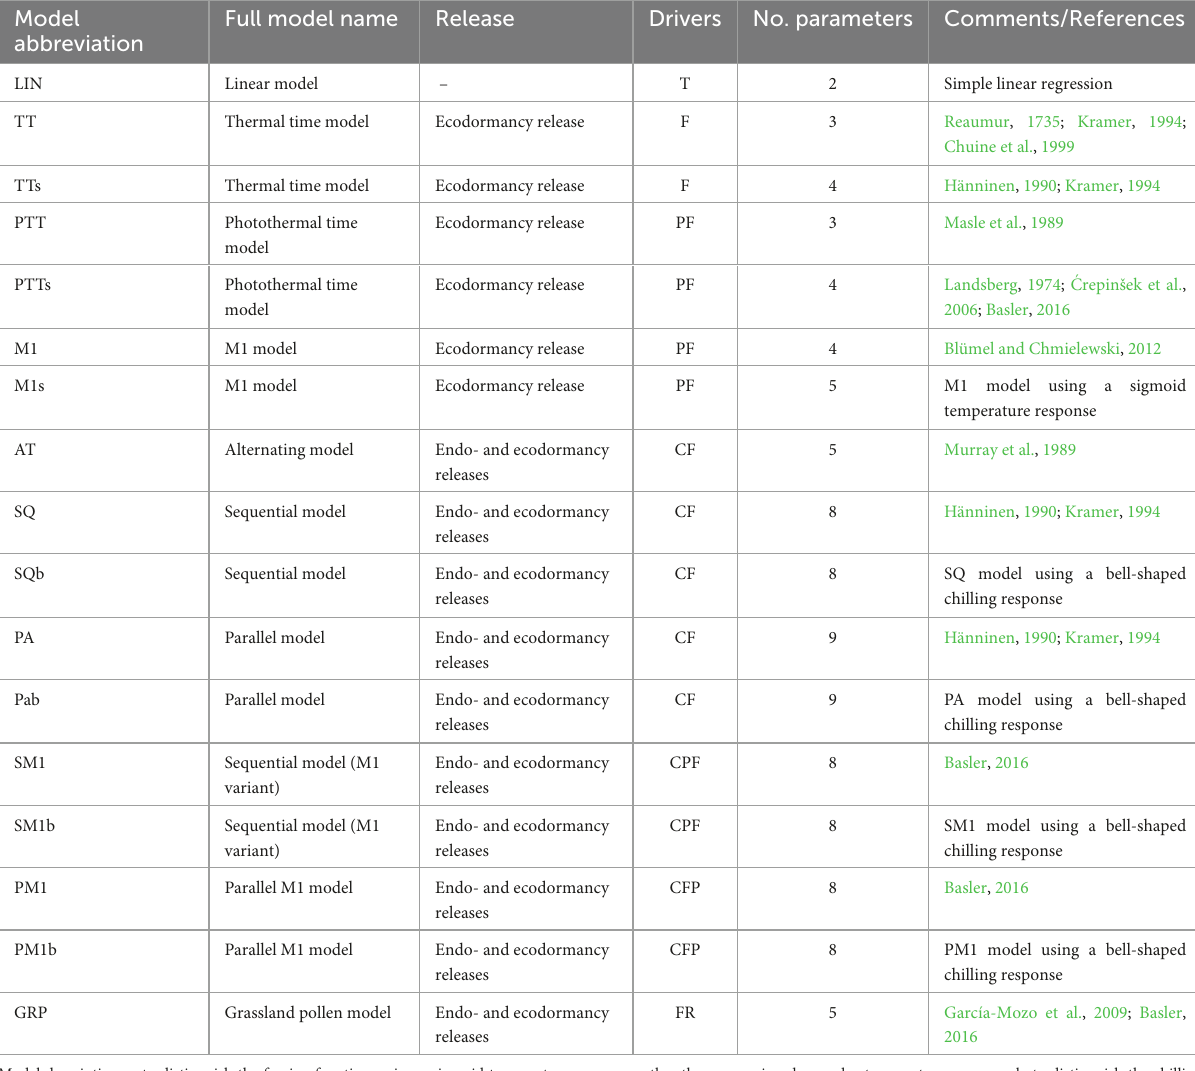
TABLE 2 Phenological models for the start of the growing season (SOS) included in this study. Model